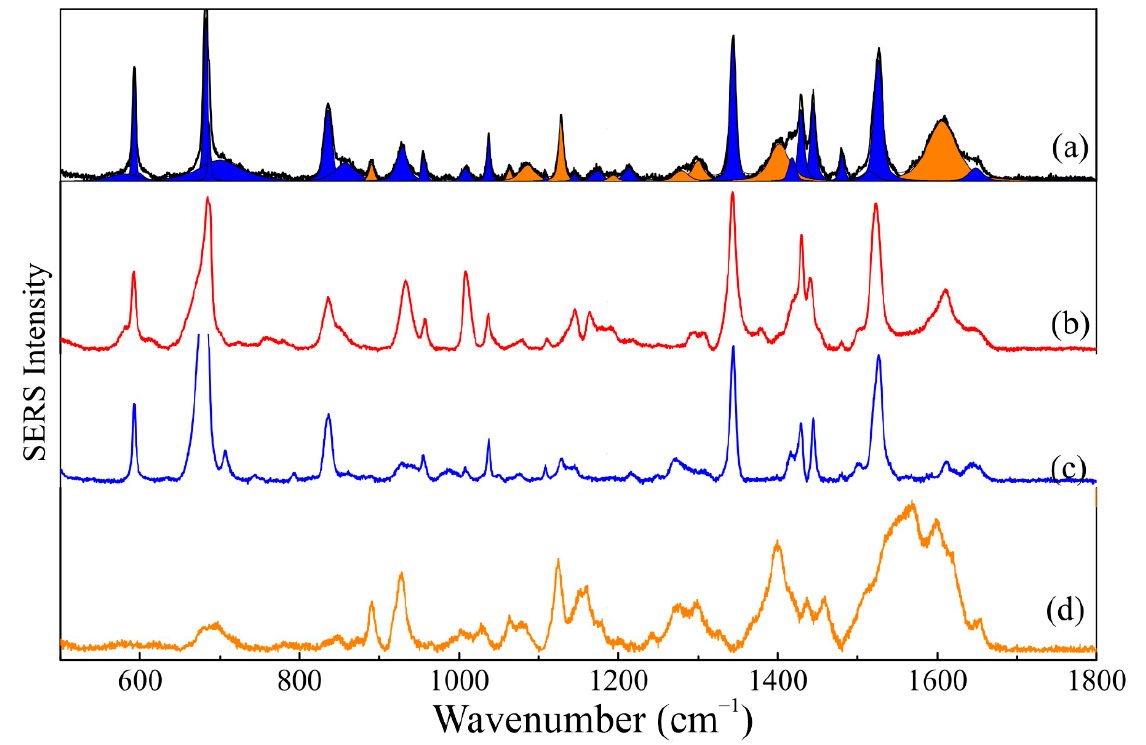
Figure 6. SERS spectra of ( a ) SLN-AlPc formulation, ( b ) physical mixture (AlPc + SLN), ( c ) solution of AlPc in alcohol, and ( d ) SLN solution of AlPc in alcohol.